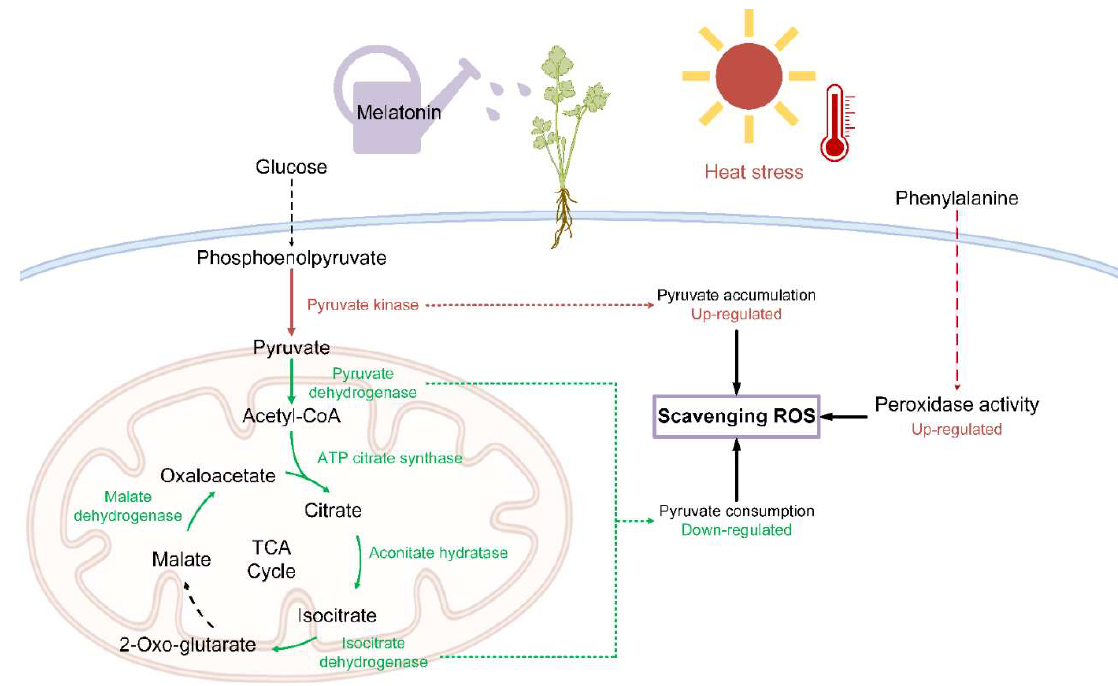
Figure 9. Schematic diagram of two pathways for scavenging reactive oxygen species (ROS) in celery under heat stress. In red, expression is elevated, and in green, expression is reduced.